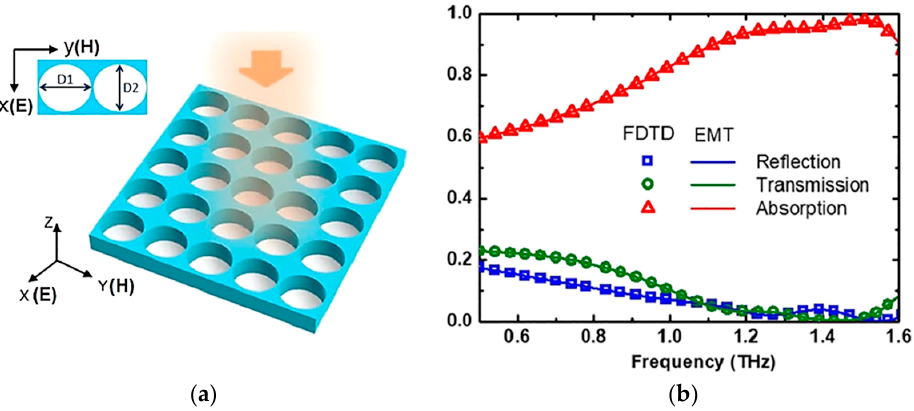
Figure 20. ( a ) Schematic of the broadband THz silicon membrane metasurface absorber (SMMA); ( b ) simulated reflection (blue), transmission (green), and absorption (red) of SMMA [57].